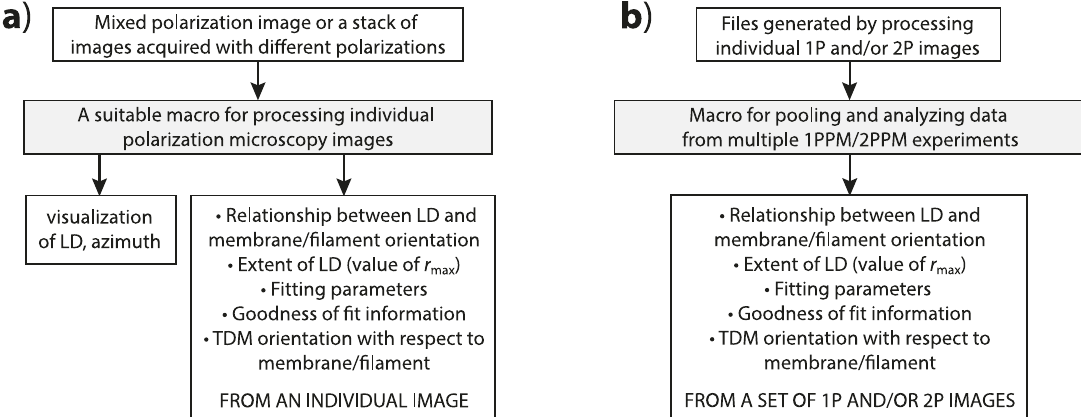
Fig. 1 Schematic representations of the core image-processing algorithms. a Macros for processing individual polarization images. b Macro for pooling and analyzing the pooled 1P and/or 2P